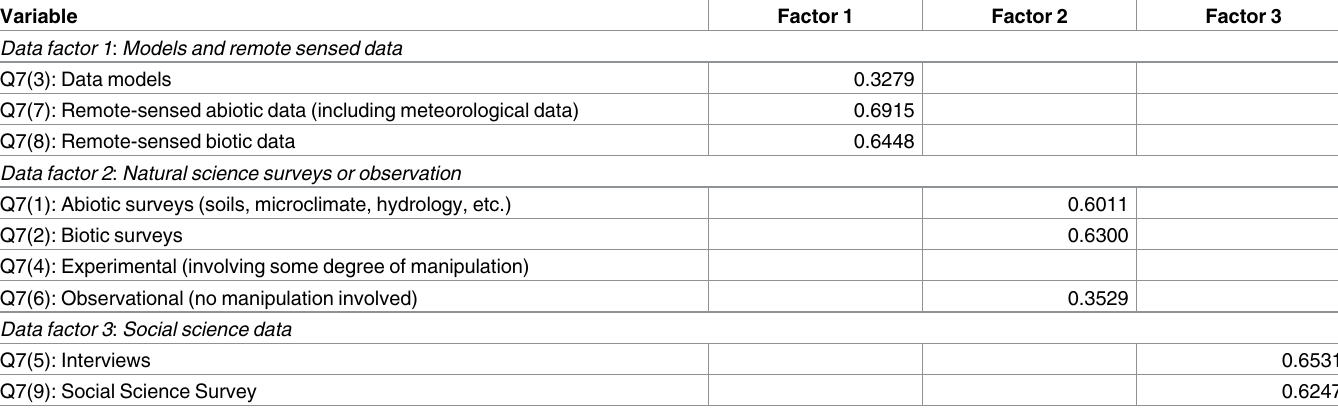
Table 2. Factor loadings for types of data